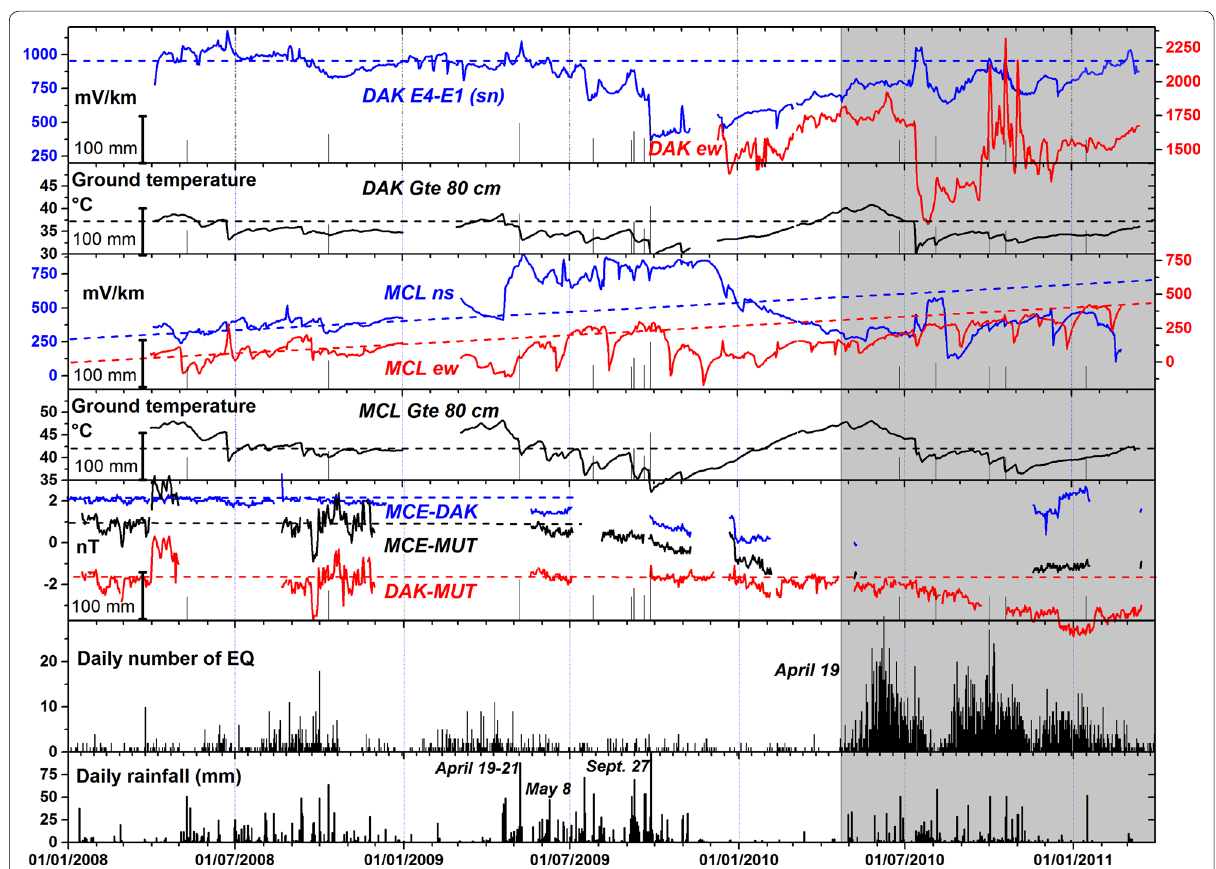
Fig. 5 Daily variations of different parameters between January 2008 and March 2011. Gray box corresponds to the 2010 seismovolcanic crisis. From top to bottom: Horizontal components of the electric field at DAK (S–N, E–W), ground temperature measured at 80 cm depth at DAK, Horizontal components of the electric field at MCL station (N–S, E–W), Ground temperature recorded at 80 cm depth at MCL, Total Magnetic field differences [ DAK – MCE ], [ MCE – MUT ], and [ DAK – MUT ], Daily number of earthquakes (PHIVOLCS document), and Daily rainfall at the local Buco Observatory. Rainfall above 50 mm is added to each plot for comparison with single parameters. Dashed lines correspond to the pre-crisis